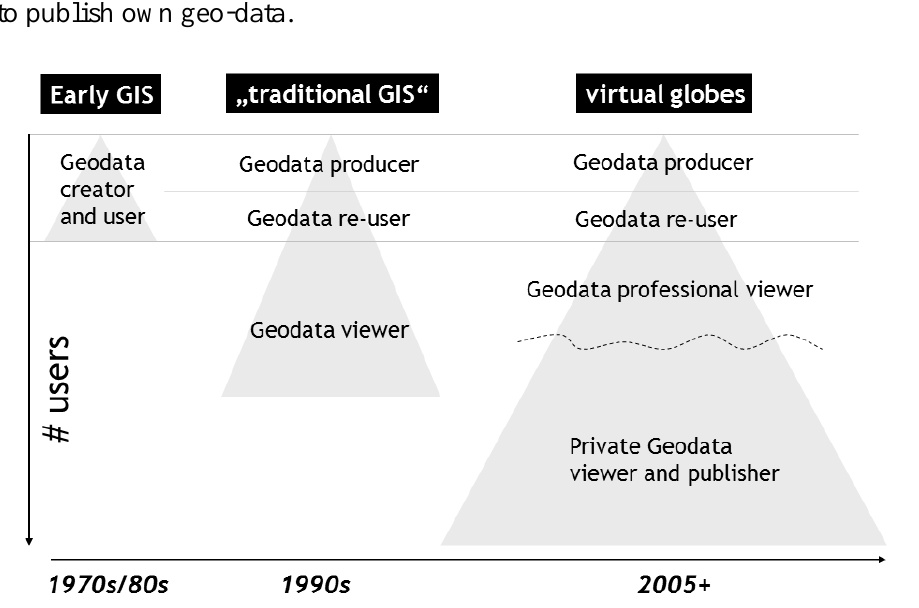
Figure 2. Virtual Globes extend the user base of spatial information by enabling the masses to publish own